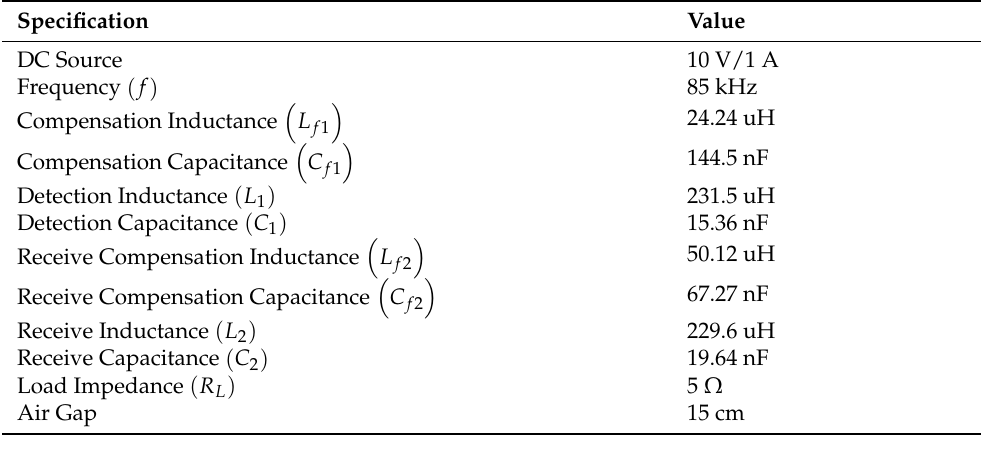
Figure 3. Test bench of the experiment. Table 1. Specifications of the test bench.